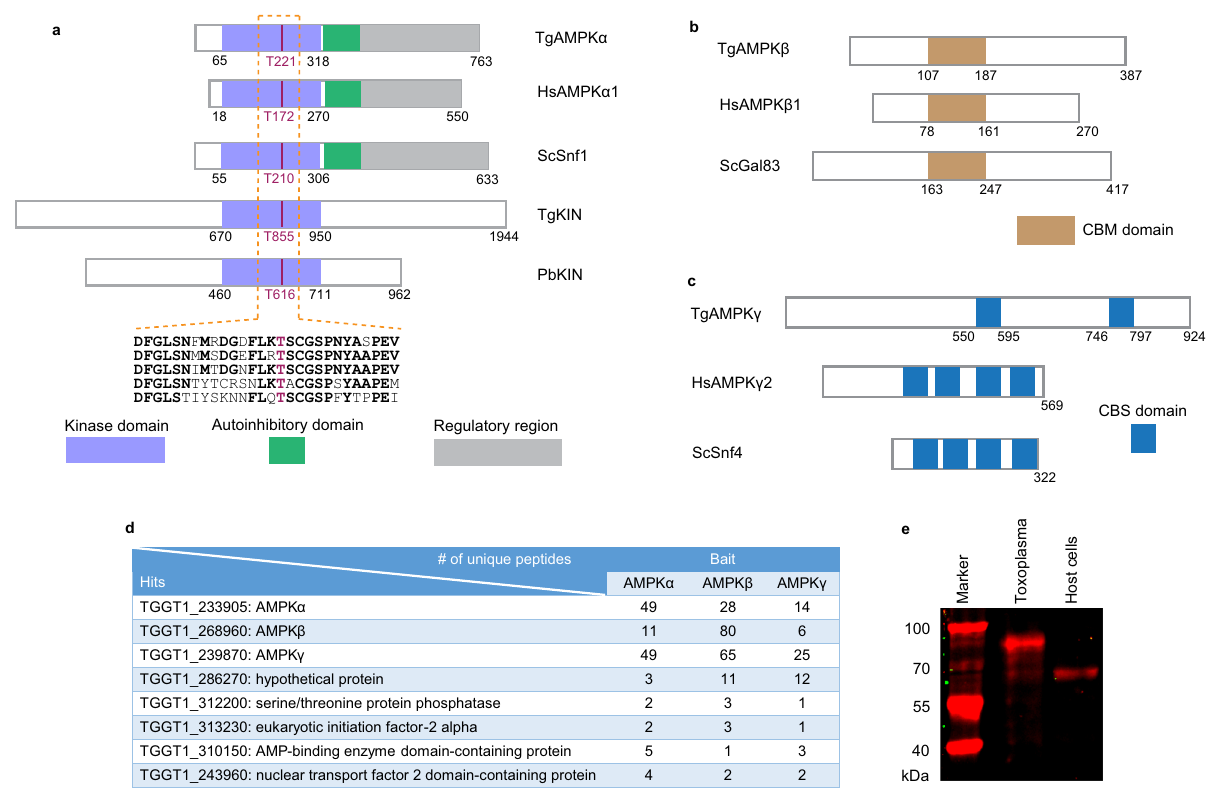
Fig. 1 | Identi fi cation and characterization of the domain structures of the AMPK complex in T. gondii . a – c domain structures of the three subunits of Tox- oplama AMPK compared with their corresponding orthologs in other eukaryotes. The human ( Homo sapiens , Hs), yeast ( Saccharomyces cerevisiae , Sc) and Plasmo- dium ( Pasmodium berghei , Pb) proteins are included for comparison. A sequence alignment (done by Clustal X2) of the activation loop in the kinase domain of AMPK α , along with the conserved threonine residue that is subjected to phos- phorylation regulation is provided in a . d transgenic strains expressing TgAMPK α - Ty, TgAMPK β -Tyor TgAMPK γ -HAwere individually used inco-IP (using antibodies against the corresponding epitope tags) experiments to identify proteins